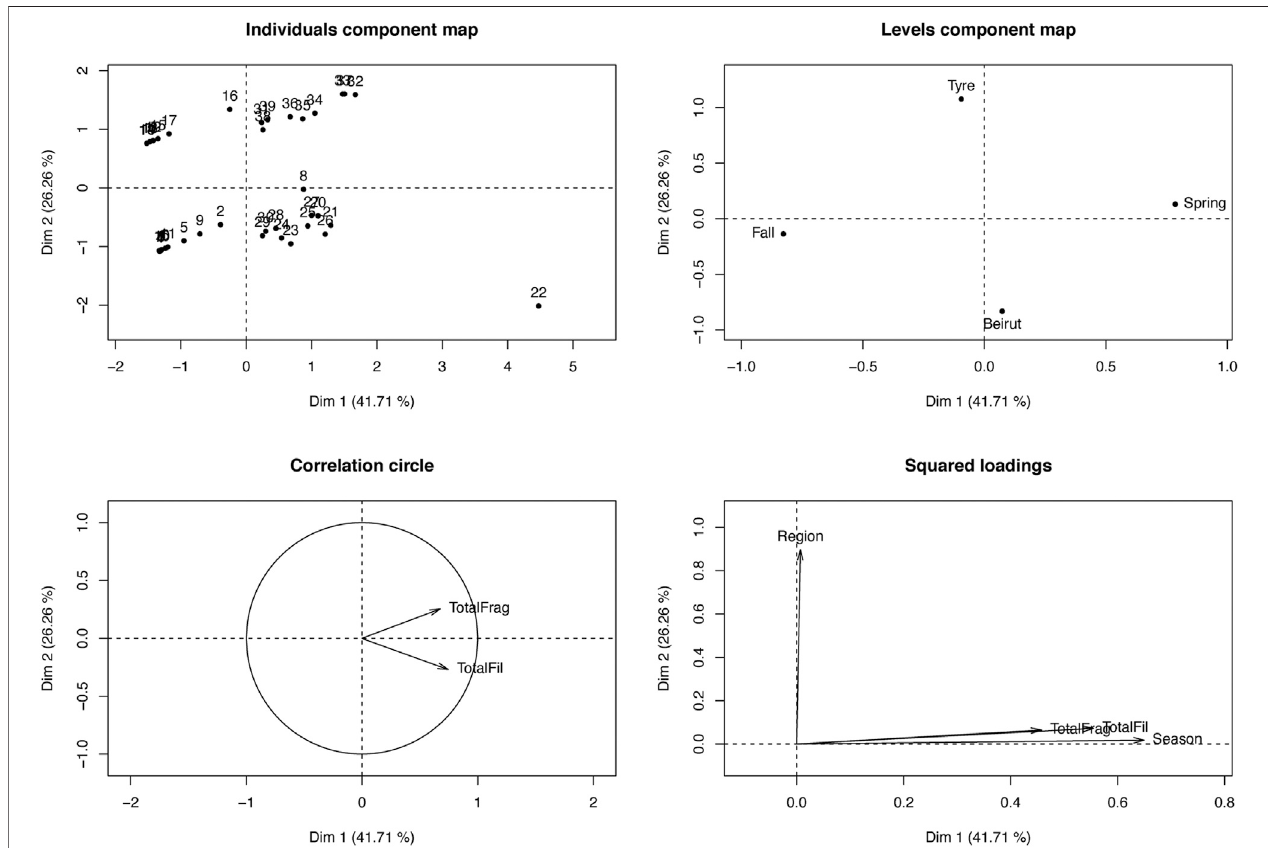
FIGURE 7 | The individual and level component maps, correlation circle and squared loadings of the PCA for both Beirut and Tyre regions.